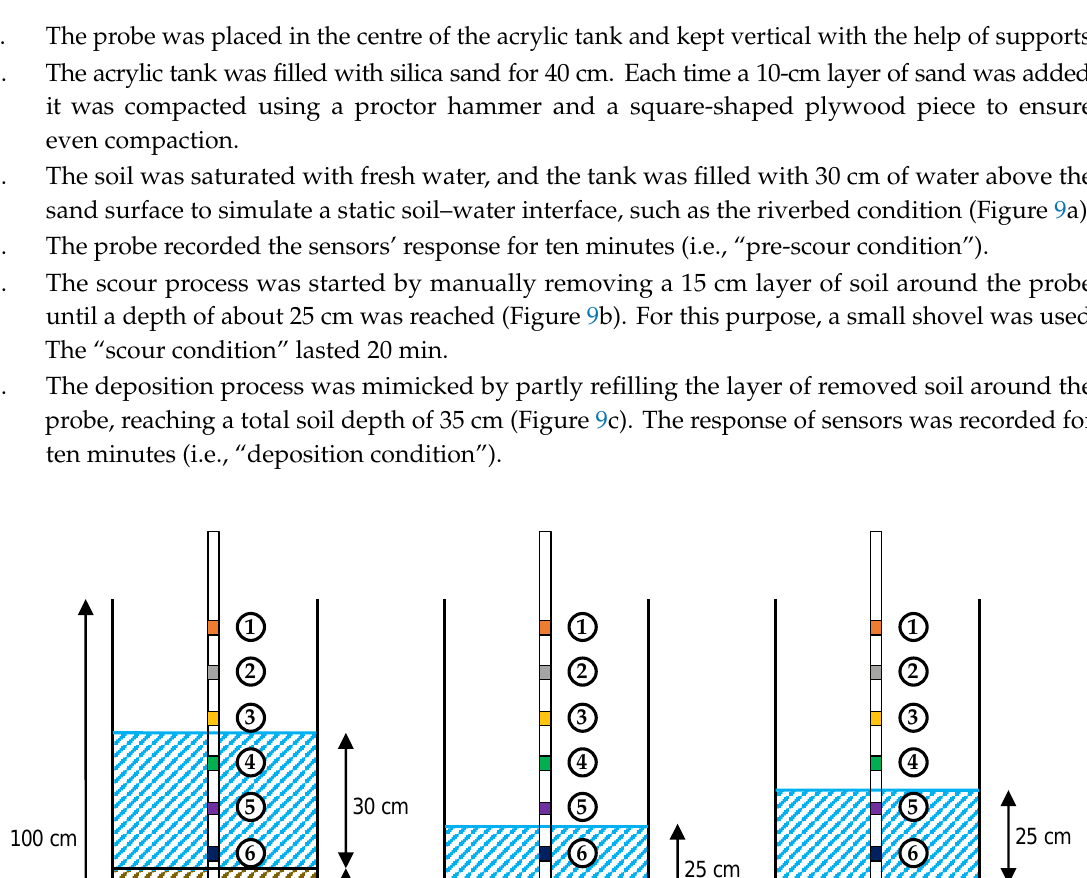
( c ) Figure 10. Static scour test showing ( a ) the pre-scour, ( b ) the scour, and ( c ) the deposition condition. The response of sensor 4 shows a drop in the permittivity from 75 (i.e., water) to 1 (i.e., air), that can be explained by the fact that the water level dropped after the soil was removed (see Figure 10b,c